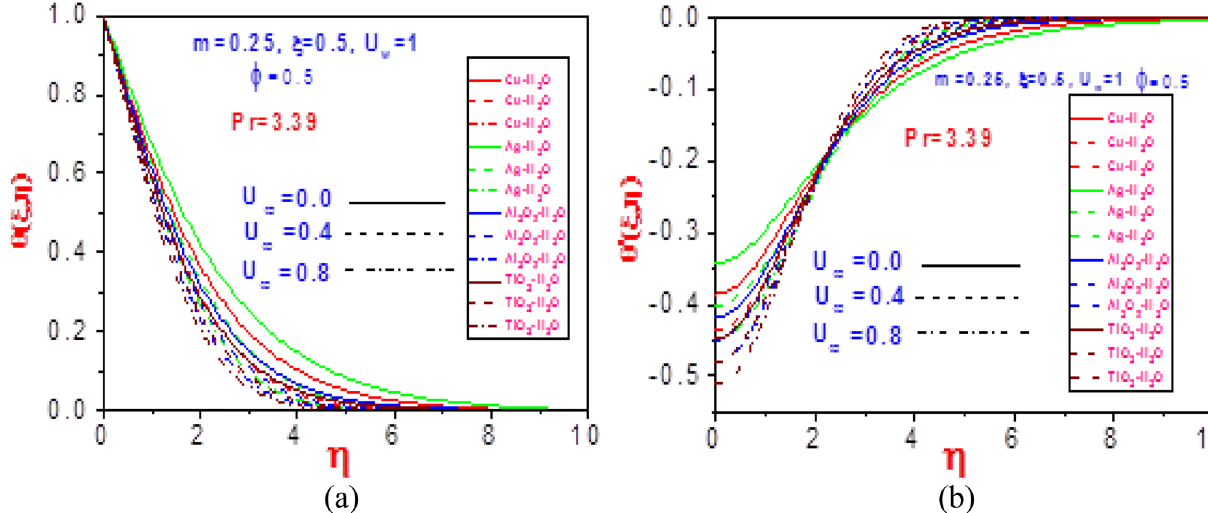
Figure 16. Profiles of ( a ) temperature θ(ξ , η) and ( b ) missing temperature slope θ ′ (ξ , η) with different values of U